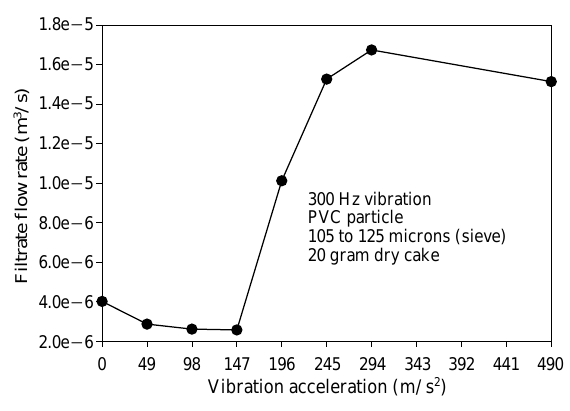
Filtrate volume collected and the corresponding filtration curve obtained during a vibration filtration